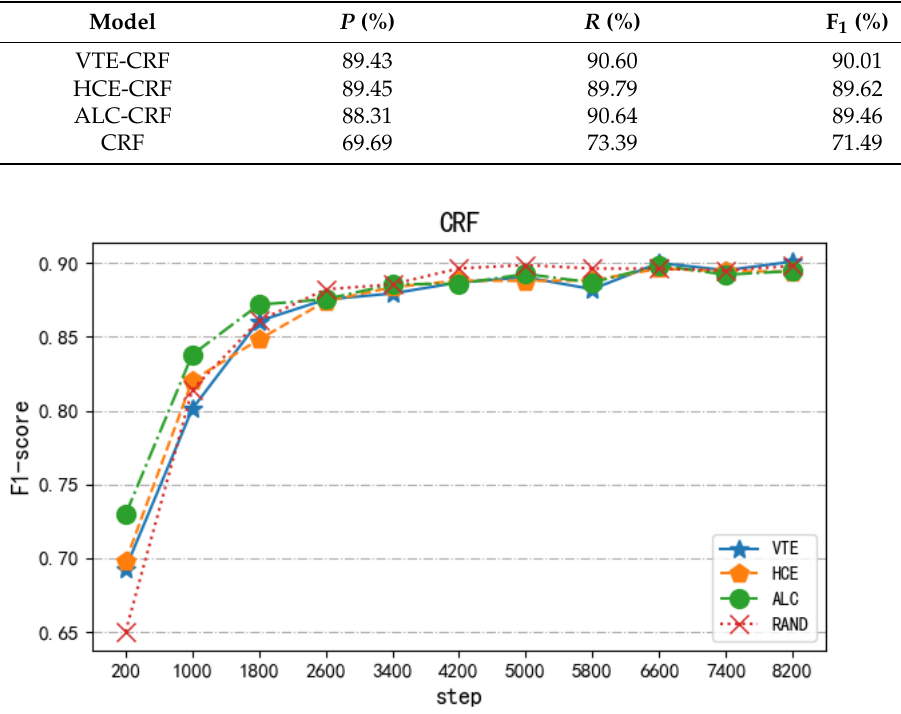
Table 5. The experimental results based on the CRF model.